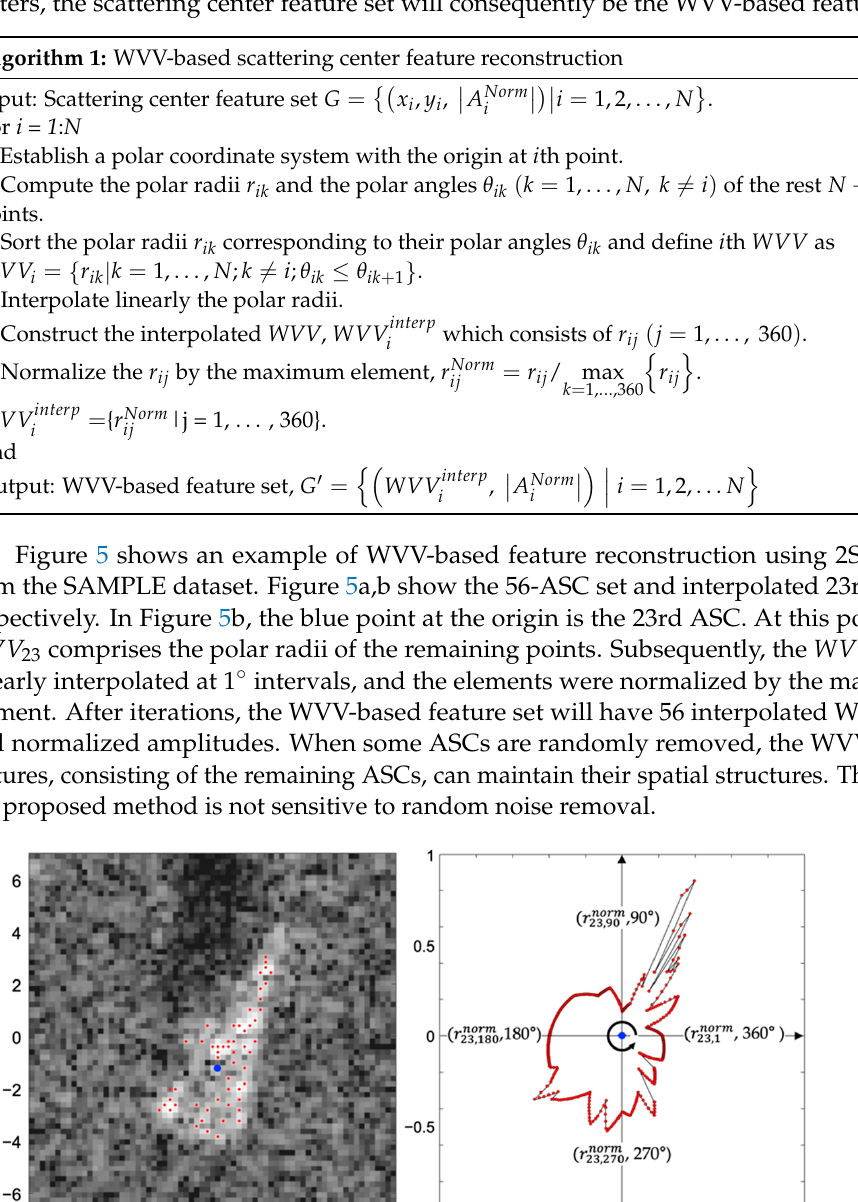
Algorithm 1: WVV-based scattering center feature reconstruction